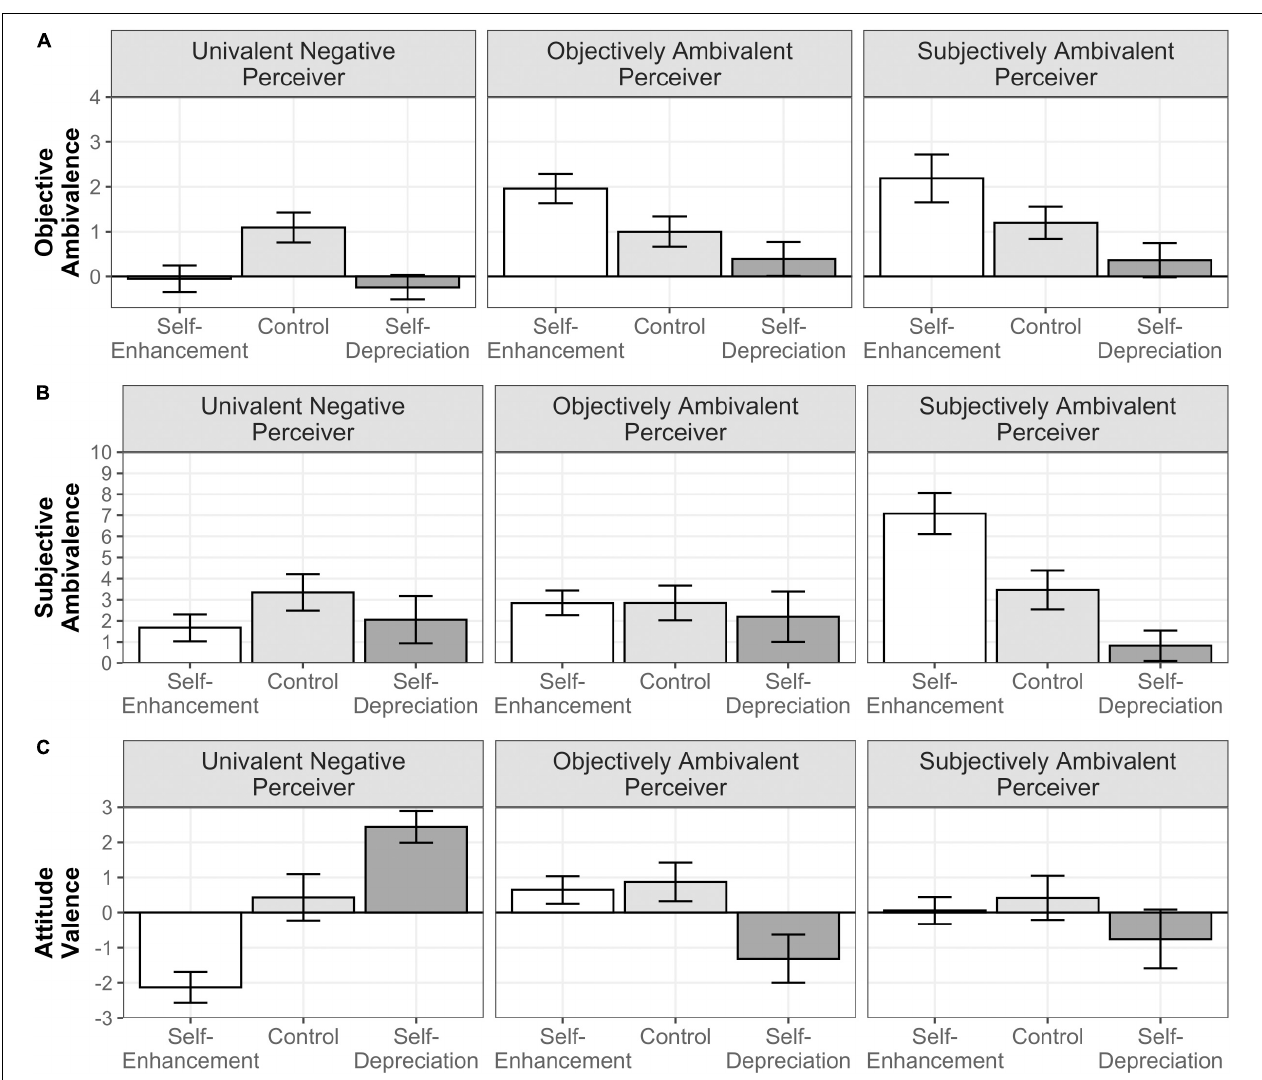
FIGURE 2 | Moderated influence of self-presentation instructions by the perceiver’s attitudinal profile on reported OA (A) , SA (B) , and attitudinal valence (C) in Study 2. Error bars represent 97.52%